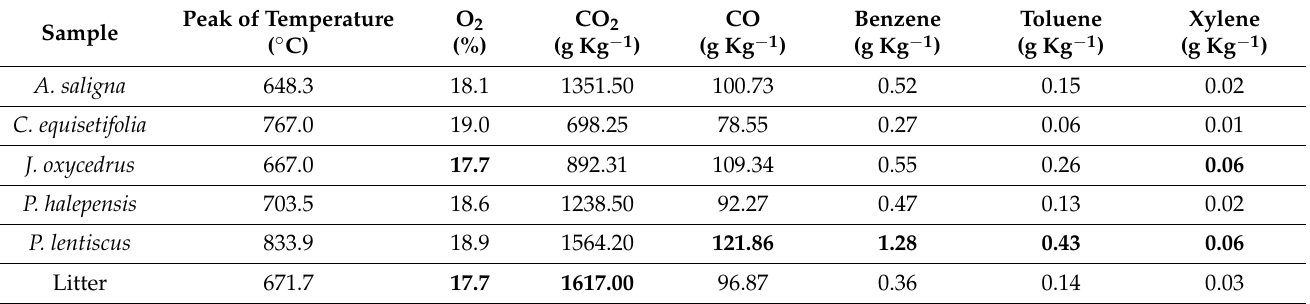
Table 2. Peak of temperature, oxygen (O 2 ), carbon dioxide (CO 2 ), carbon monoxide (CO) and BTX emitted during combustion experiments for each sample. Maximum values are indicated in bold for each compound, except for O 2 , where minimum values are